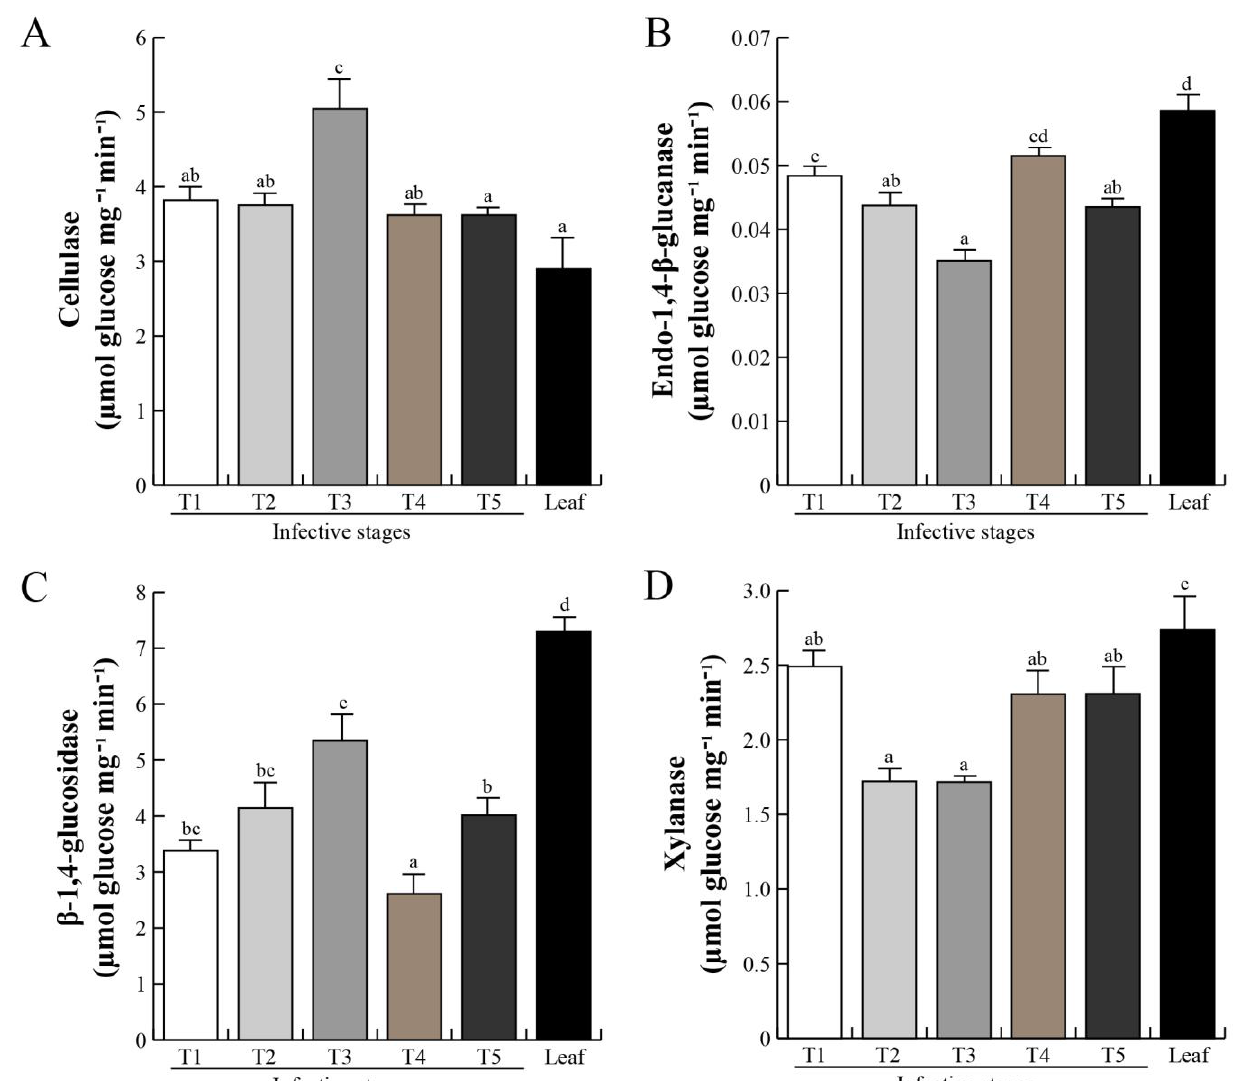
Figure 5. Cell wall-degrading enzyme activities from infective stages. The enzymatic activities were assayed with total protein extracts from the P. calyculatus infective stages and leaves. ( A ) Cellulase, ( B ) endo − 1,4 − β − glucanase, ( C ) β − 1,4 − glucosidase, and ( D ) xylanase. Bars represent mean ± SE (n = 10), different letters above the bars indicate significant differences among infective stages ( p < 0.05 according to ANOVA and Tukey test).